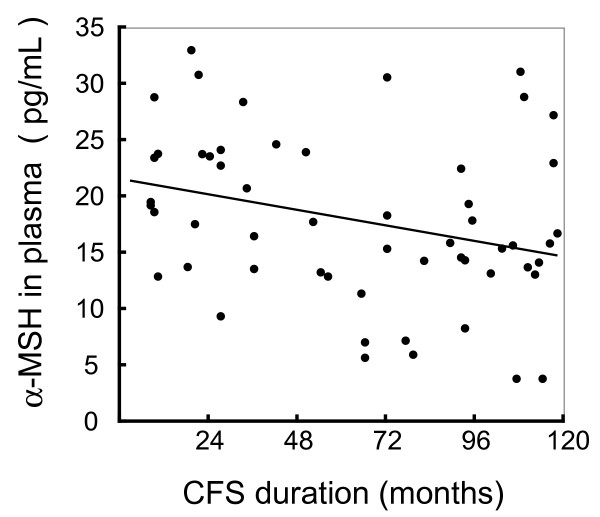
Correlations between α-MSH concentrations and duration of CFS. A significant correlation was observed between α-MSH and duration of the disease in CFS patients (r = -0.27, p < 0.05).